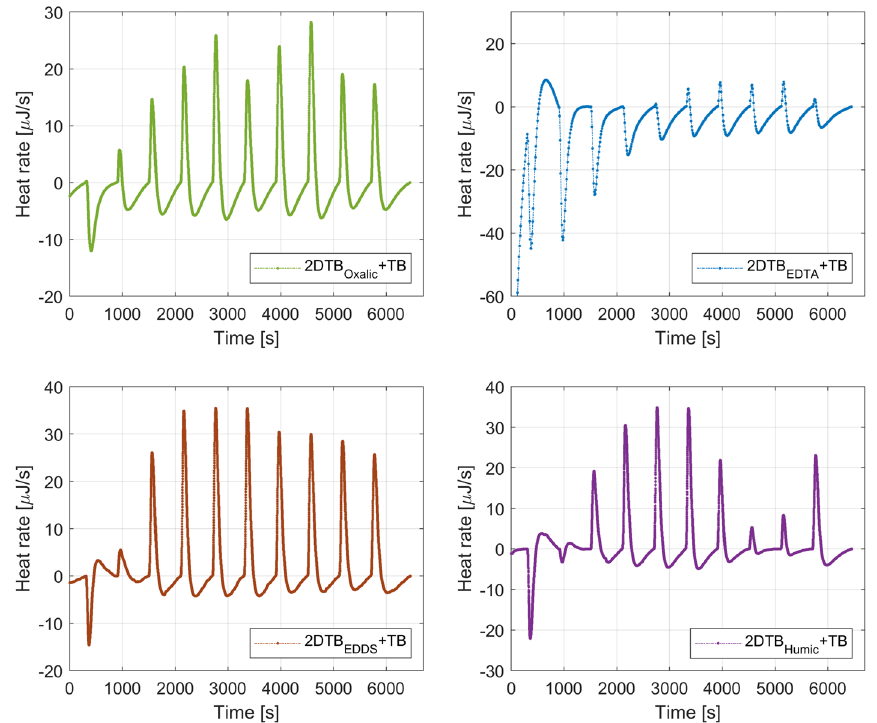
Fig. 8 Thermograms for the interaction of 2D * TB chelating and